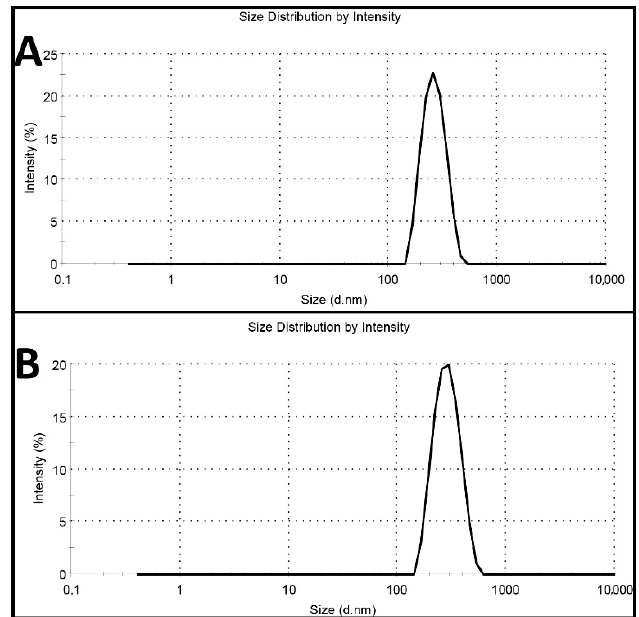
Figure 1. Intensity profile of ( A ) blank polybutylcyanoacrylate (PBCA) nanoparticles and ( B ) cisplatin-loaded PBCA nanoparticles.